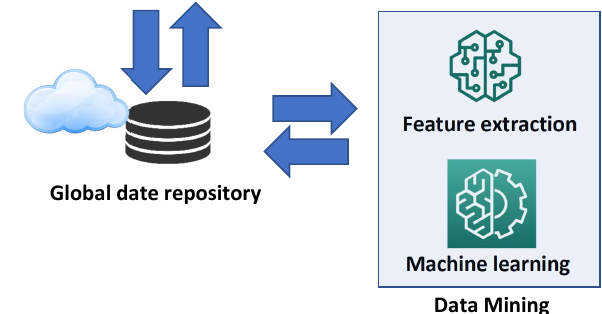
Figure 3. Chemical risk classification model in the pharmaceutical